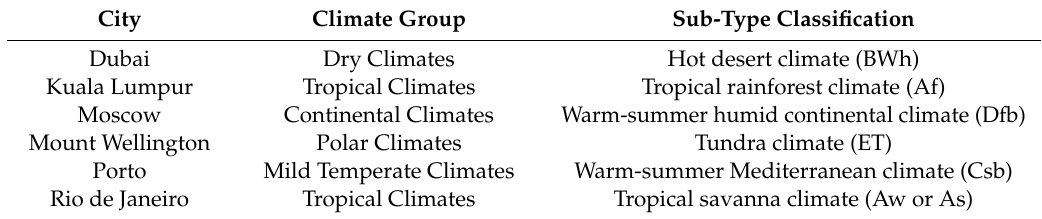
Table 1. Selected cities for this analysis